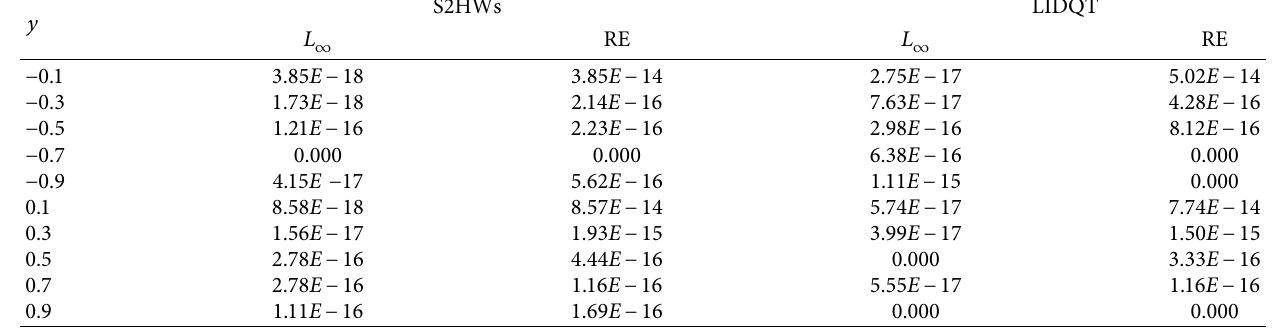
Table 2: Absolute ( L ) and relative errors (REs) of problem (45) via S2HWs and LIDQT for α � − 1 , R � − 1 . 5 , φ � 0 . 9. ∞ S2HWs LIDQT y L ∞